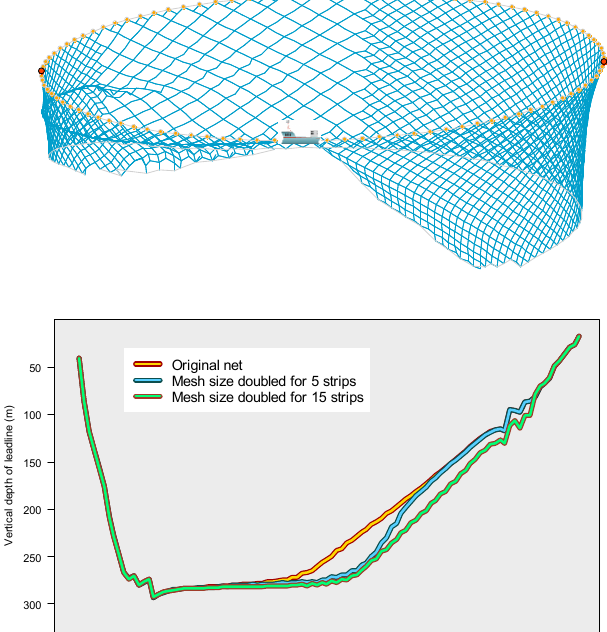
Figure 10. Three-dimensional shape for the net (top panel, five-strip large mesh net only) and the vertical depth of the entire length of the lead line at the end of shooting (bottom panel) for the original net, and the alternative net with its mesh size doubled for 5 strips and 15 strips.